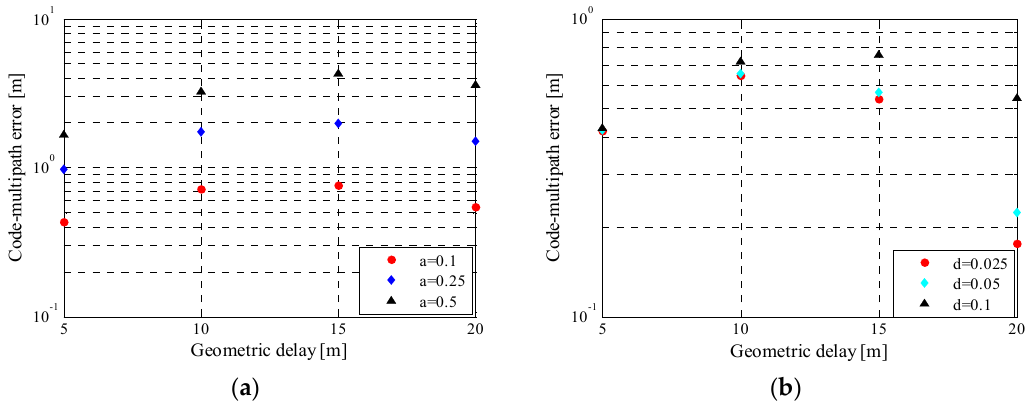
Figure 11. Multipath error envelop for NSCC(19) with different MDRs ( a ) and different correlator spacings ( b ).